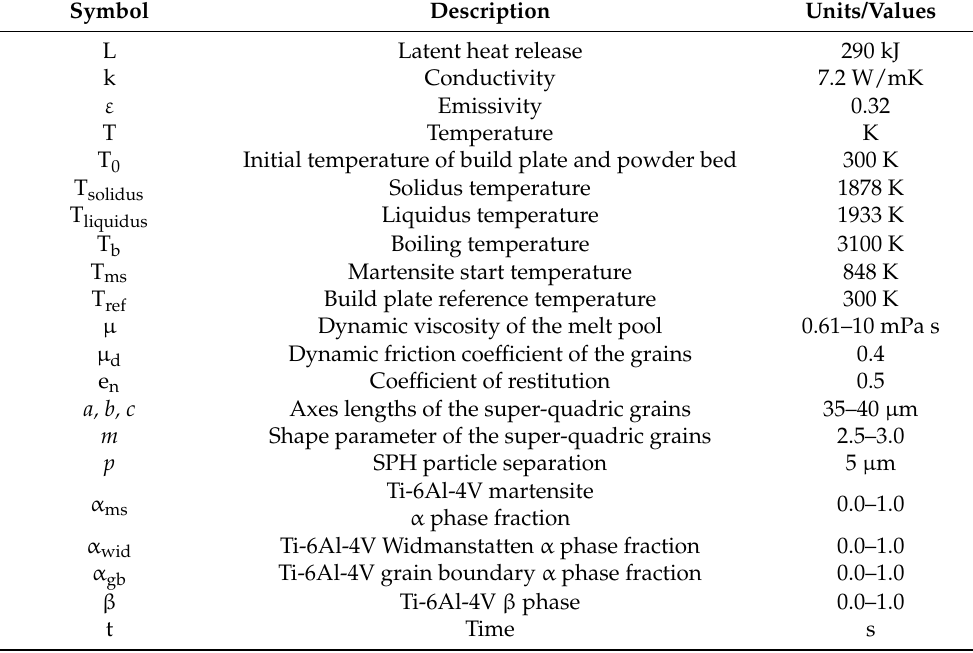
Table 1. Definition of symbols and, where applicable, their values, used in this study. Material parameters are obtained from